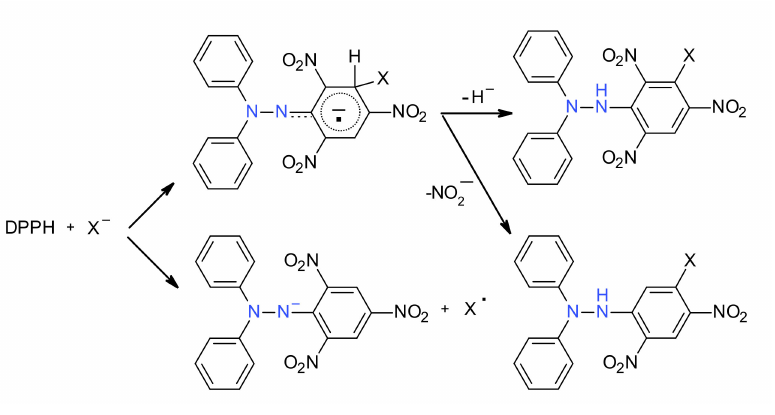
Figure 17. Reaction of DPPH · with a nucleofile X −